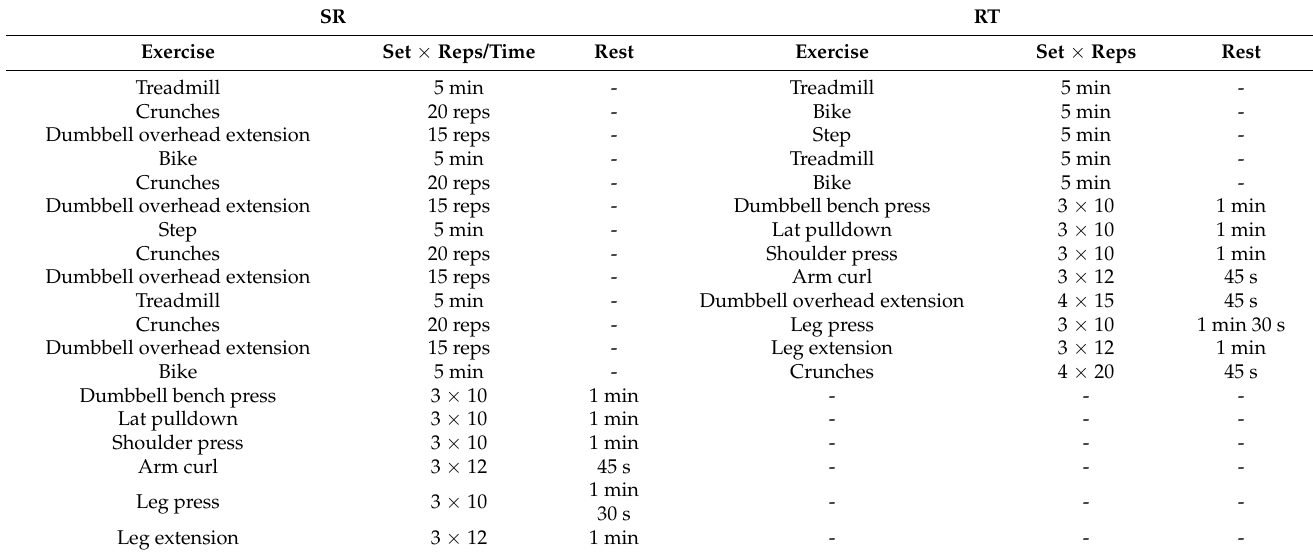
Table 2. Training protocols.